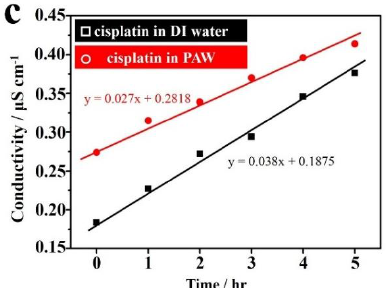
Figure 7. Conformation of cisplatin in DI water and PAW. ( a ) The absorption spectra of cisplatin in DI water and PAW. ( b ) The PL spectra of cisplatin in DI water and PAW with an excitation wavelength of 350 nm. ( c ) The conductivities of cisplatin solutions in DI water and PAW with time [77].